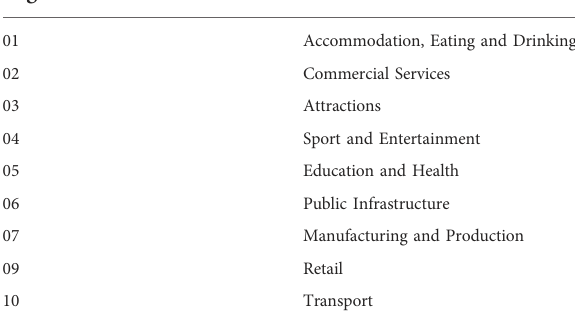
TABLE 1 POIs classi fi